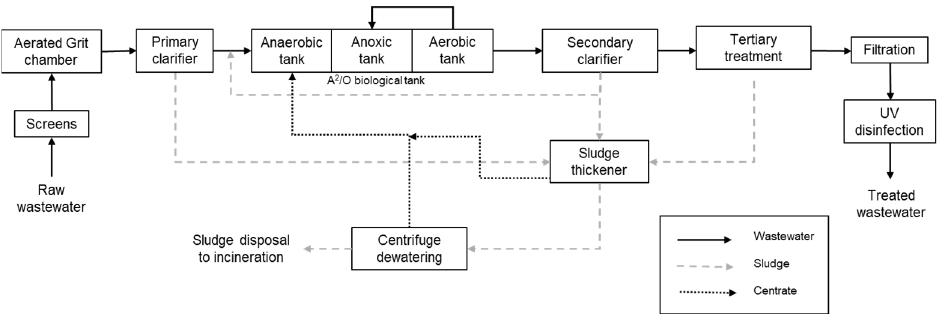
Figure 3. Scheme of the example WWTP.